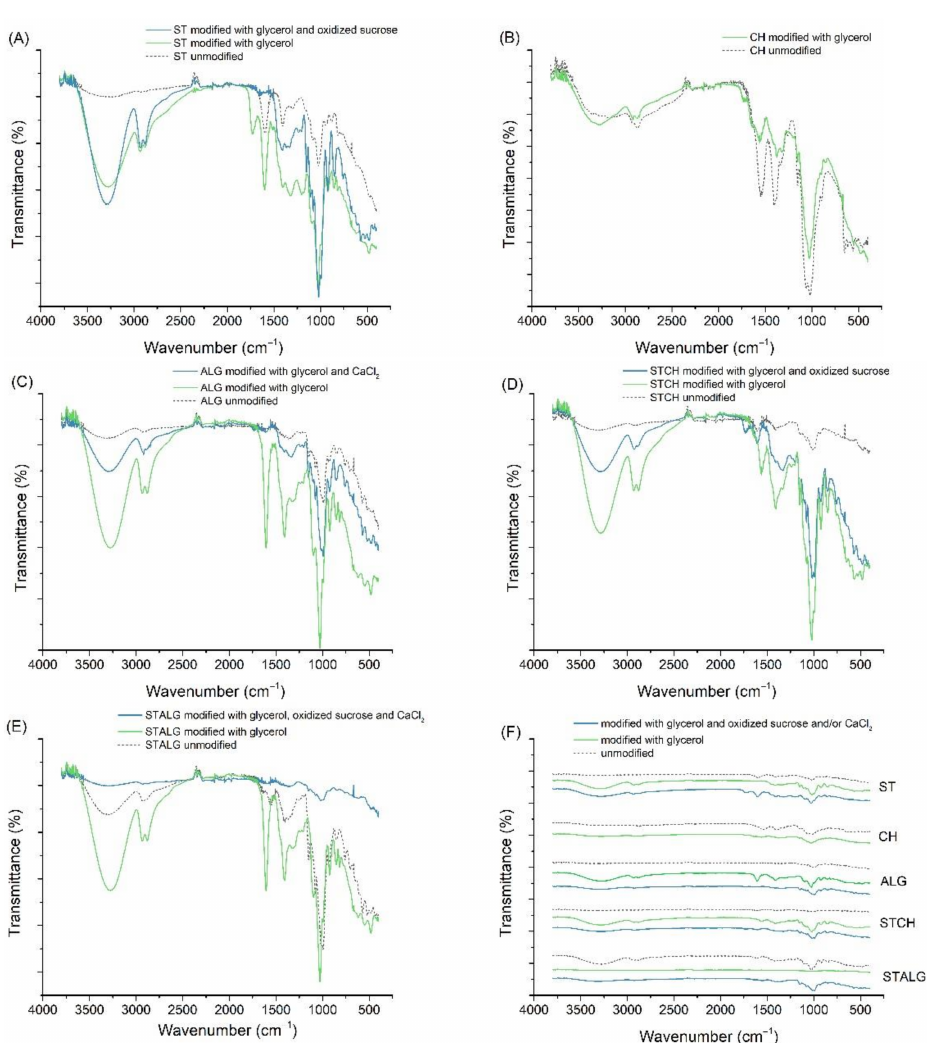
Figure 8. FTIR spectra of ST films ( A ), CH films ( B ), ALG films ( C ), STCH films ( D ), STALG films ( E ) and a summary of all spectra ( F